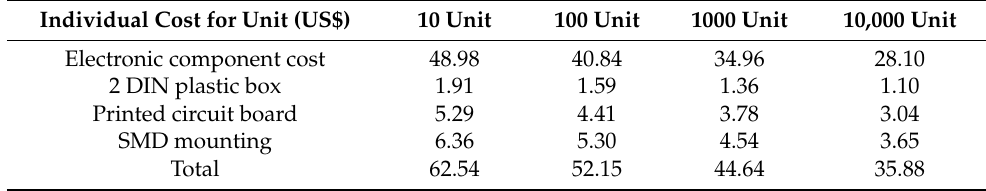
Table 5. Mass production cost.